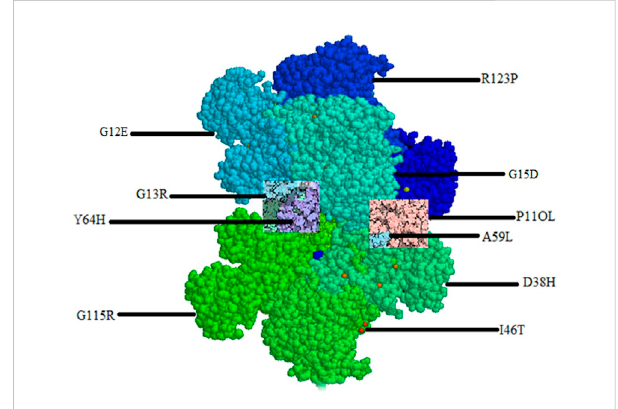
FIGURE 3 Mapping of most deleterious